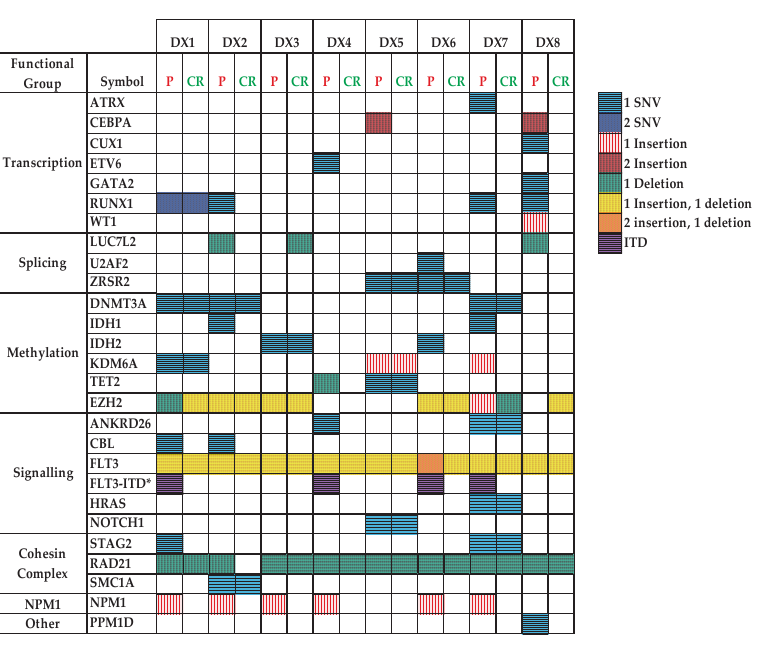
Figure 1. The mutational spectra of all somatic variants (pathogenic/benign/VUS) and their corre- sponding functional groups at disease presentation and after CR1/CR2. The coloured boxes indicate the types of variants detected in the study SNV/insertion/deletion/ITD as depicted in the legend. P refers to samples collected at presentation, and CR refers to samples collected after remission (CR1/CR2). * Refers to the internal tandem duplication